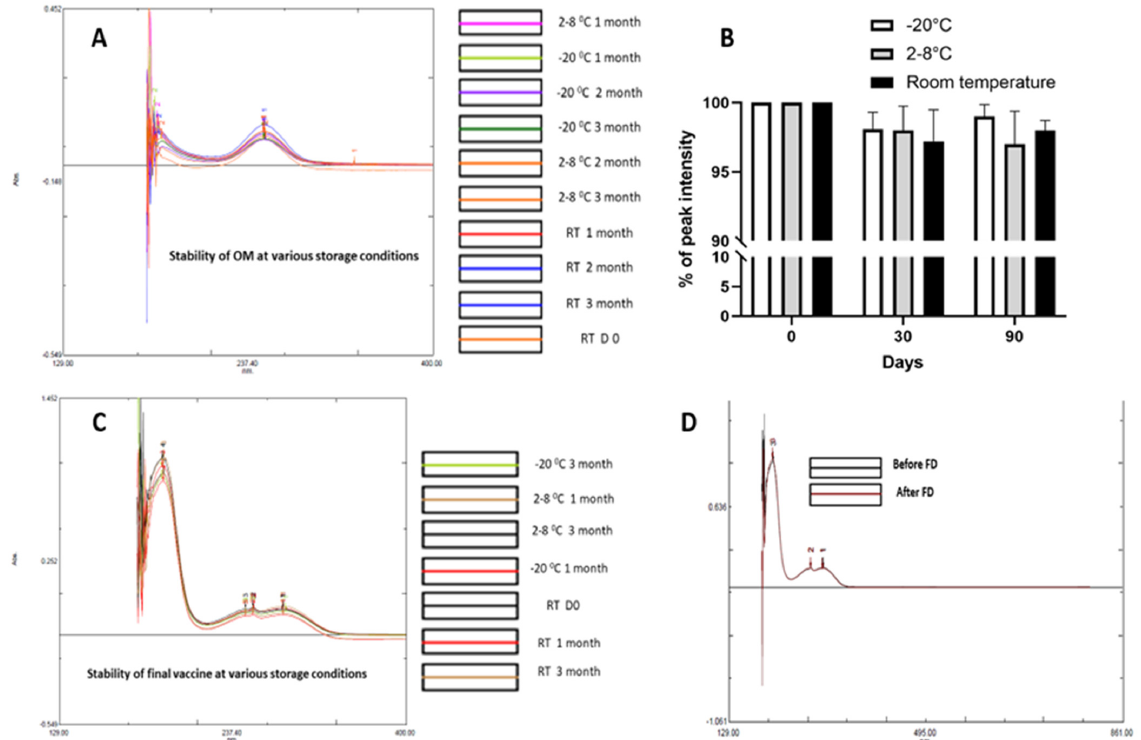
Figure 8. Assessment of the stability of various vaccine elements at various storage conditions. ( A ) OM, ( B ) hapten, ( C ) final vaccine and ( D ) effect of freeze-drying. ( A ) OM, ( B ) hapten, ( C ) final vaccine and ( D ) effect of